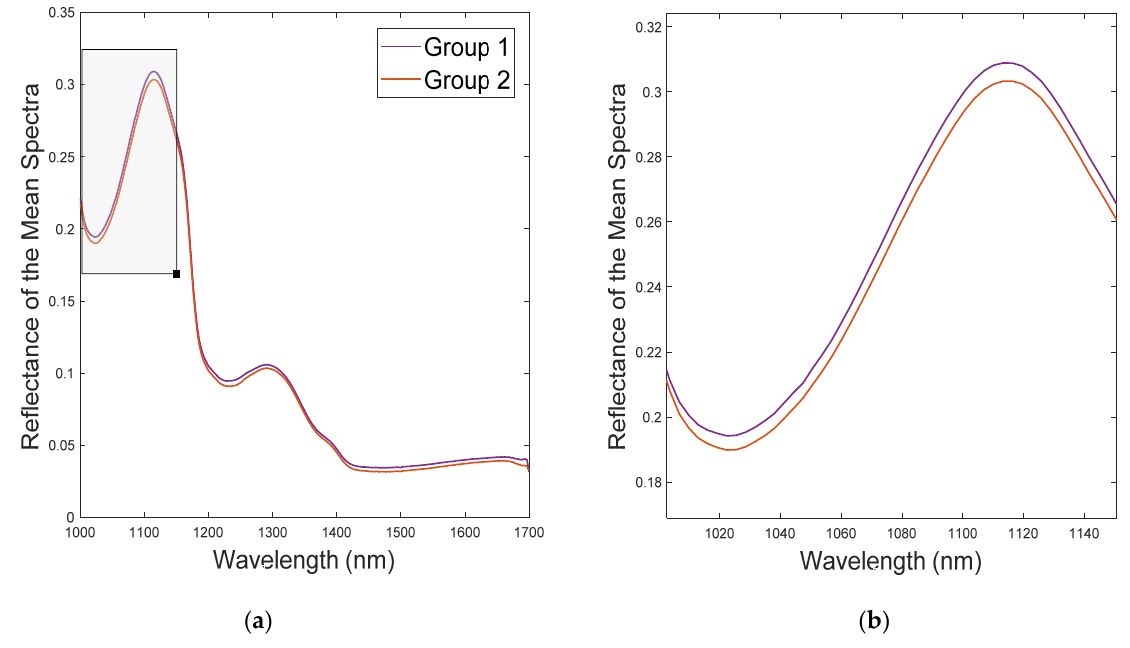
Figure 6. Reflectance of the mean spectra of the two groups determined according to their WBSF values: ( a ) represents the full spectrum (1000–1700 nm) captured by the NIR-HSI camera employed; ( b ) zoom of the 1010–1460 nm area.